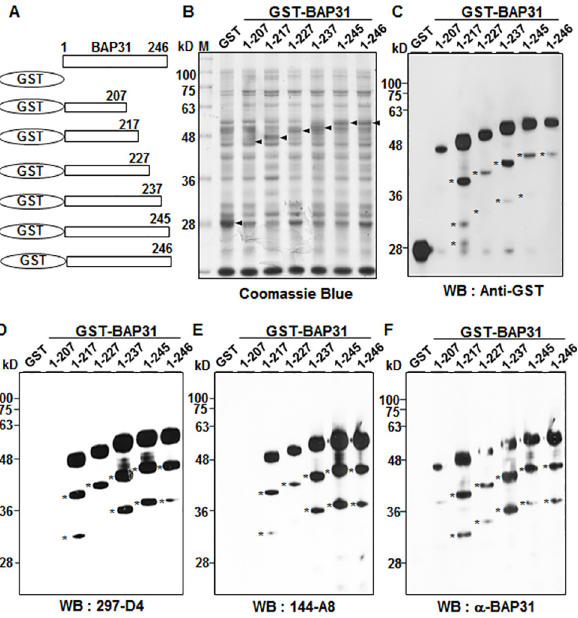
Fig 3. Fine epitope mapping of 297-D4, 144-A8, and α -BAP31 antibodies. (A) Schematic diagram of recombinant BAP31 fragments (residues 1 – 207, 1 – 217, 1 – 227, 1 – 237, 1 – 245, and 1 – 246) used in this study. (B) Individual fusion proteins were expressed in bacteria as fusion proteins with GST tag at the N-terminus and stained with Coomassie brilliant blue after SDS-PAGE. (C-F) Western blot analysis of GST-BAP31 fusion proteins with anti-GST (C), 297-D4 (D), 144-A8 (E), and α -BAP31 (F) antibodies. The asterisks indicate partial degradation products of GST-BAP31 fusion proteins.